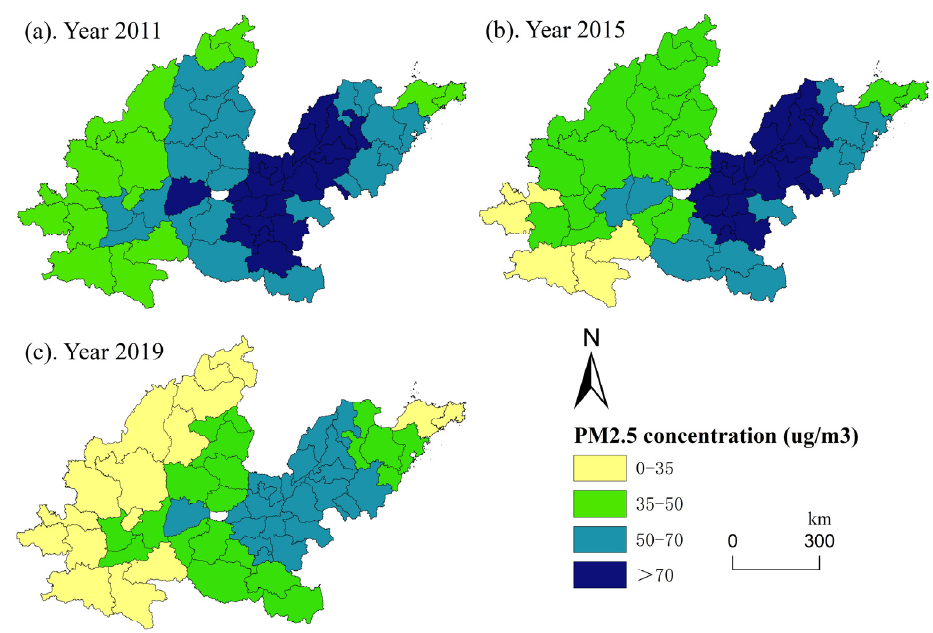
Figure 4. Spatial distribution of PM 2.5 concentrations.